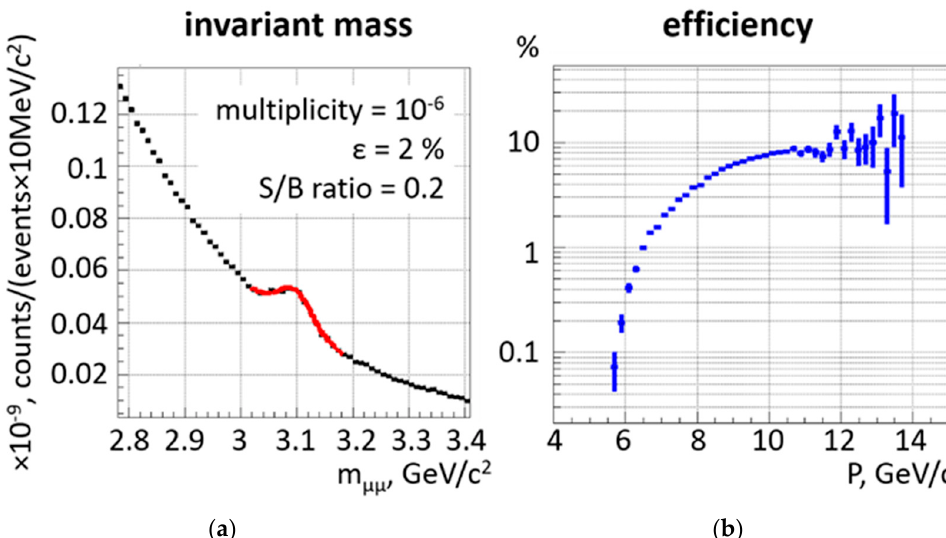
Figure 8. ( a ) Reconstructed dimuon invariant mass spectrum calculated for central Au + Au collisions at 8 A GeV/c using the PLUTO code including subthreshold J/ ψ production [9] (see text). ( b ) Efficiency of J/ ψ meson reconstruction as a function of J/ ψ momentum.